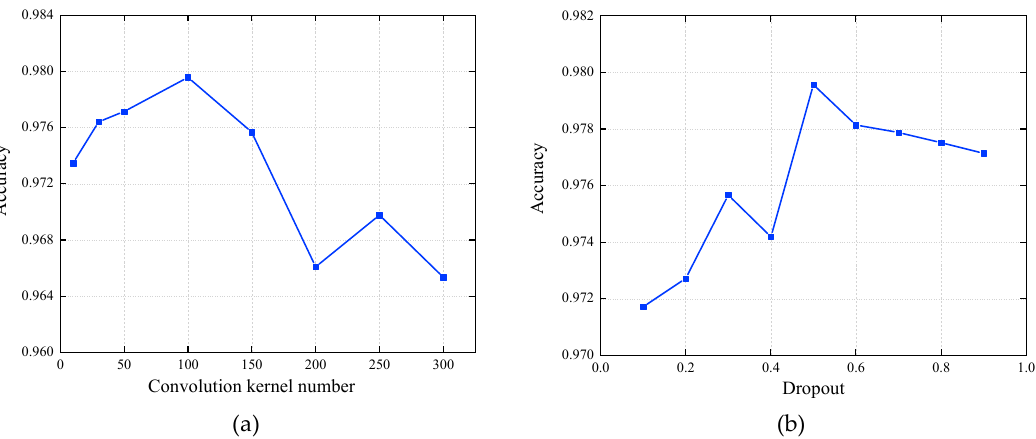
Figure 8. E ff ect of parameters on identification accuracy: ( a ) Convolution kernel number and